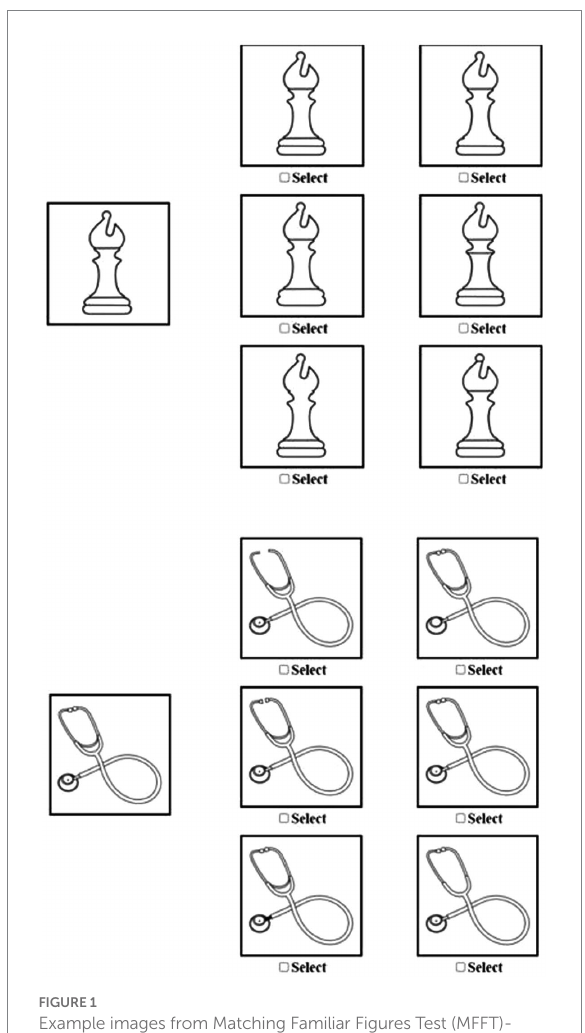
FIGURE 1 Example images from Matching Familiar Figures Test (MFFT)-